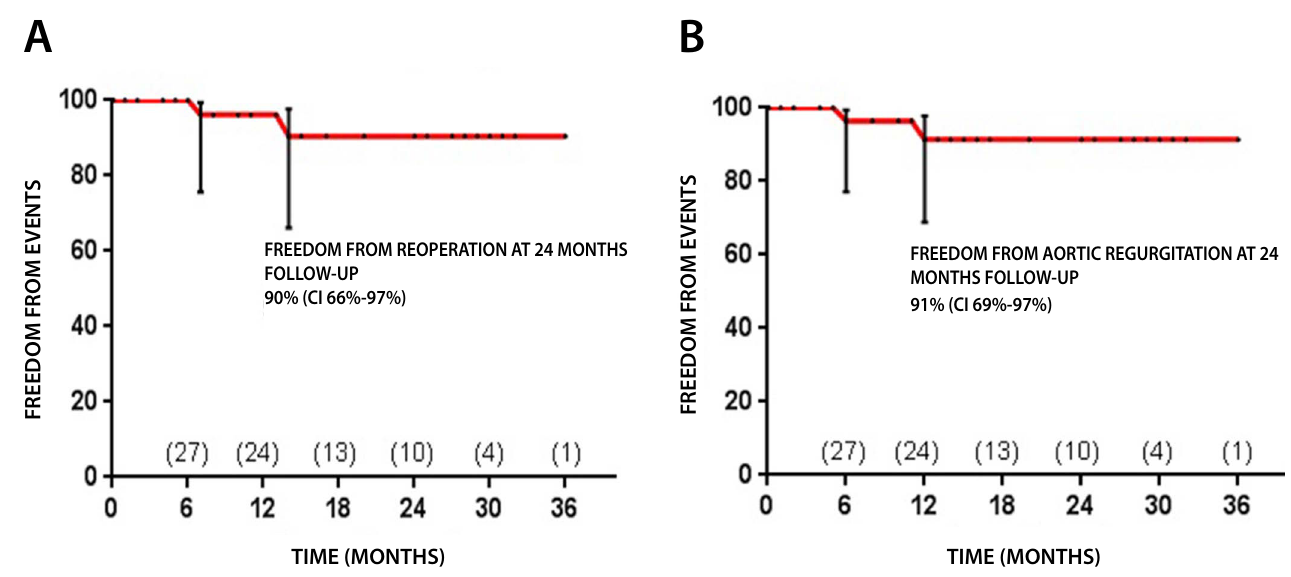
Fig. 4 - A - Freedom from reoperation. B - Freedom from aortic